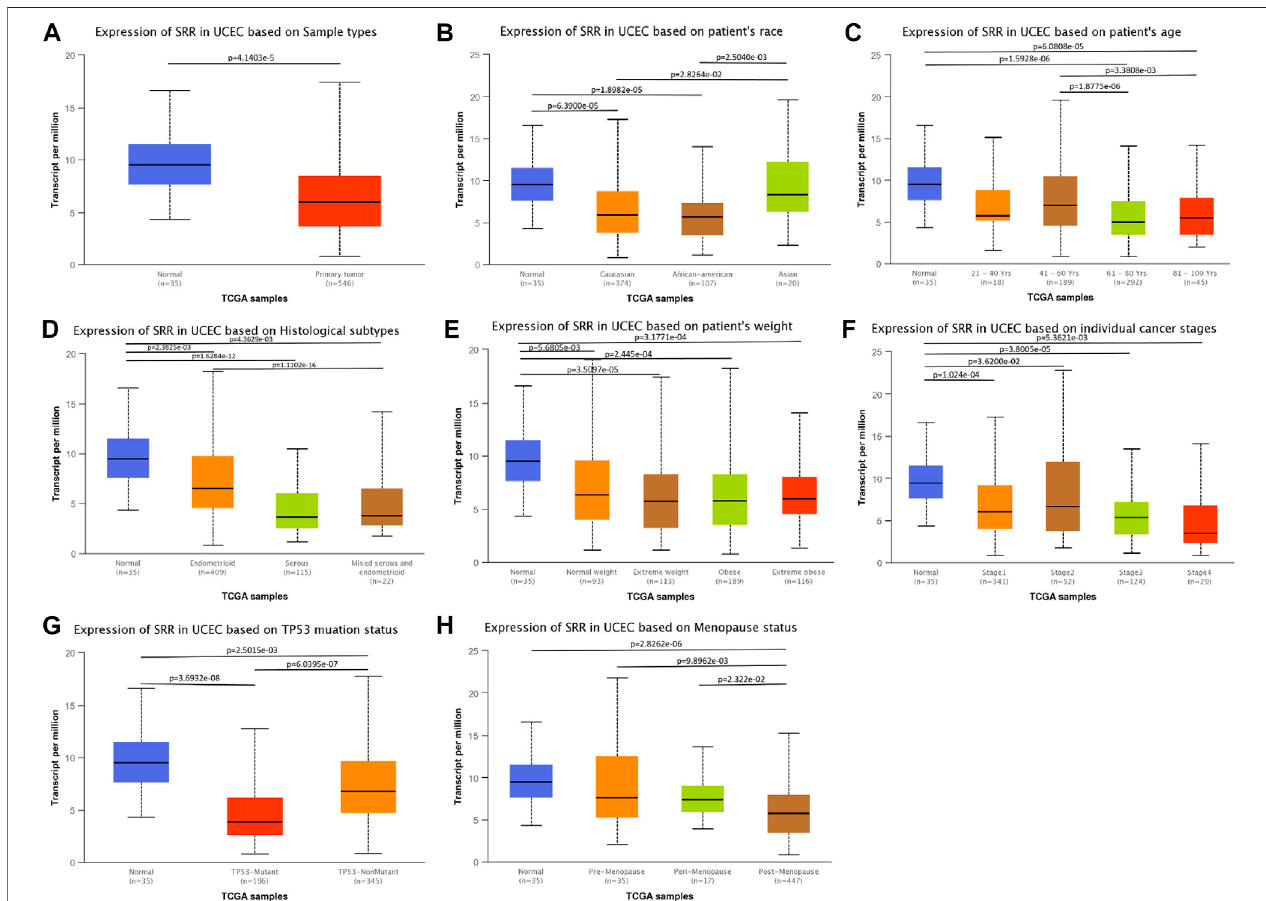
FIGURE 8 | Associations between SRR expression and different clinicopathological variables including sample types (A) , patient ’ s race (B) , patient ’ s age (C) , histological subtypes (D) , patient ’ s weight (E) , cancer stages (F) , TP53 mutation status (G) , and menopause status (H) in TCGA UCEC patients using the UALCAN